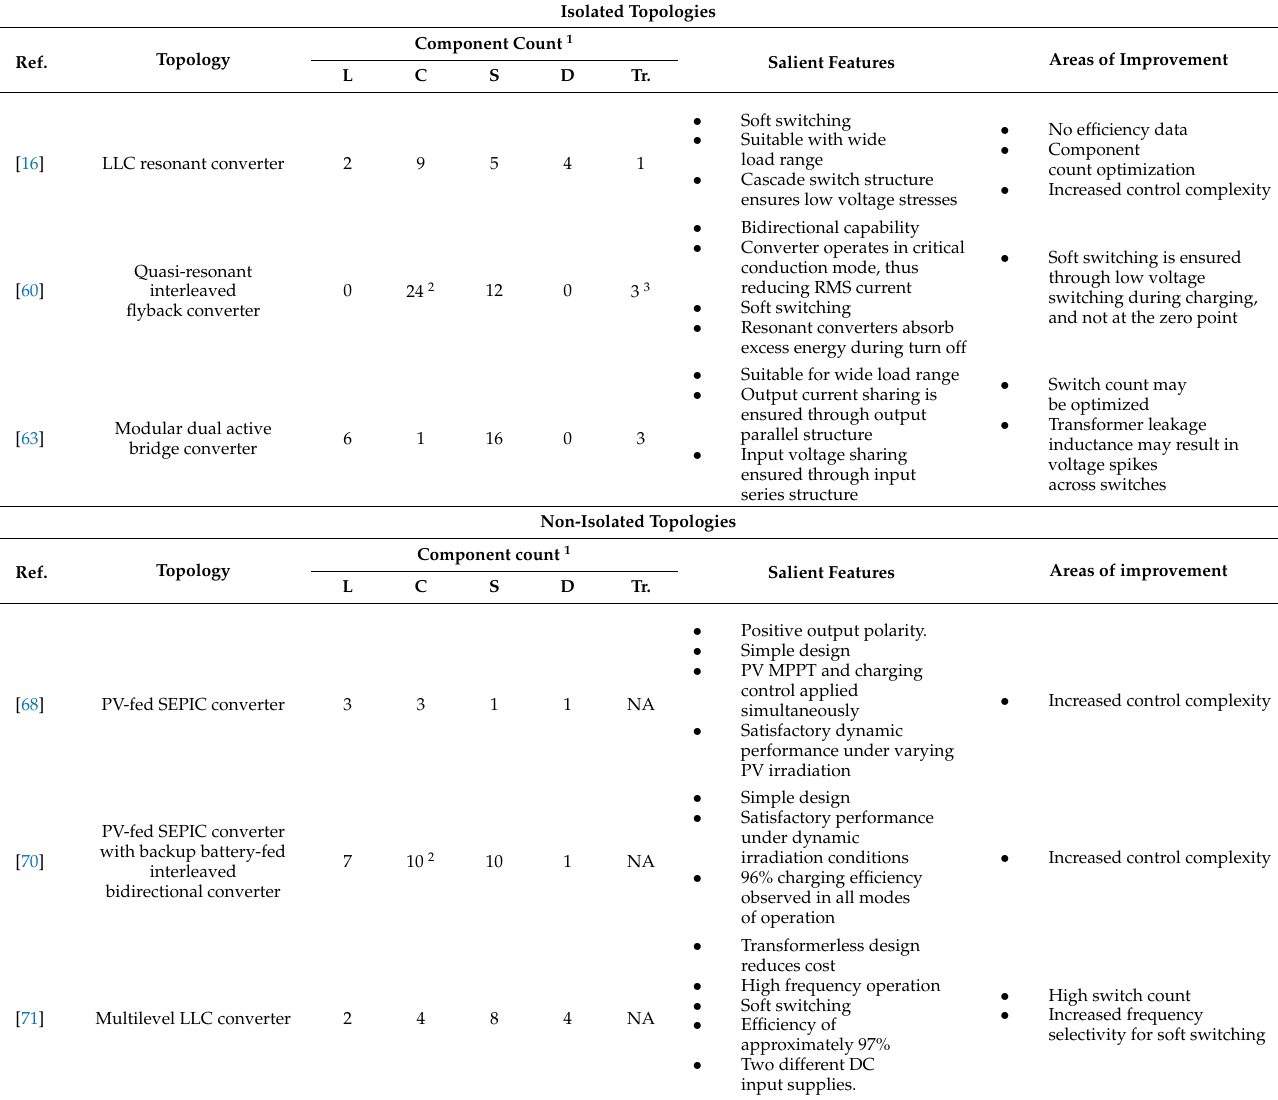
Table 3. Summary of off-board charger DC-DC